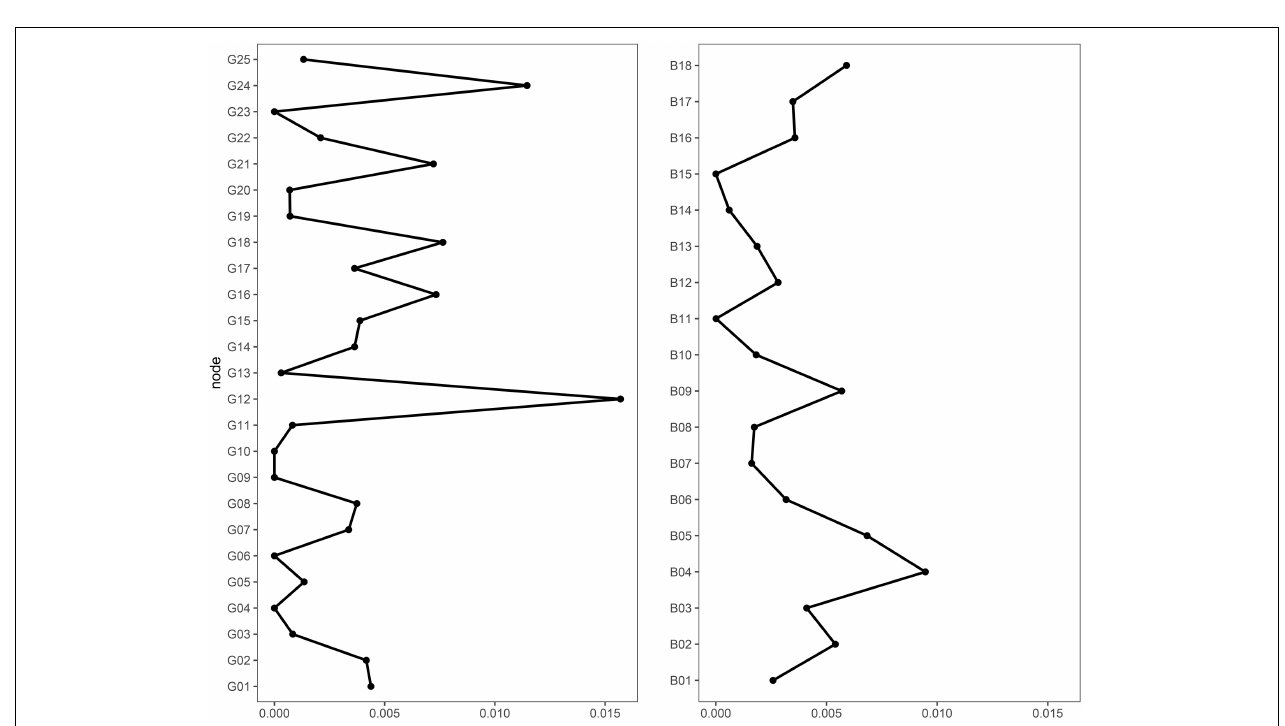
FIGURE 2 | Bridge strength centrality (on the x axis) of goals and behaviors. See Tables 3 , 5 for specific goals and behaviors and their corresponding number.